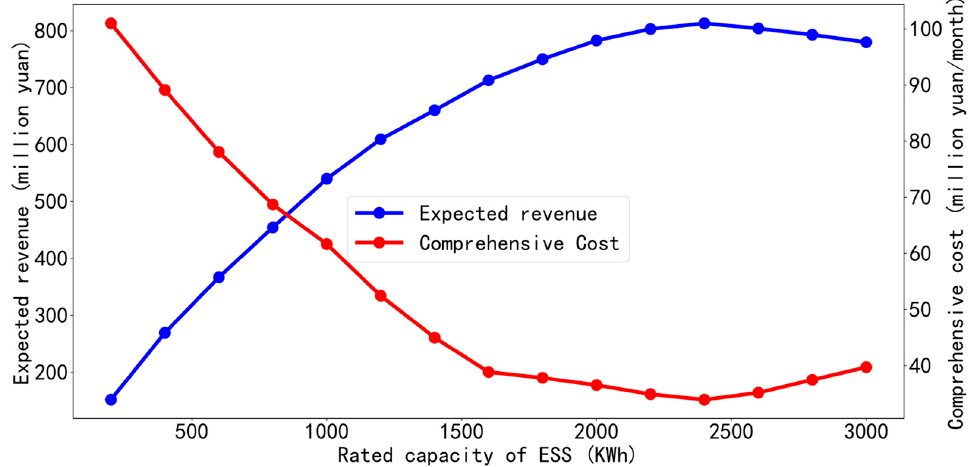
Figure 6. PSO to calculate the annualized return iteration results.